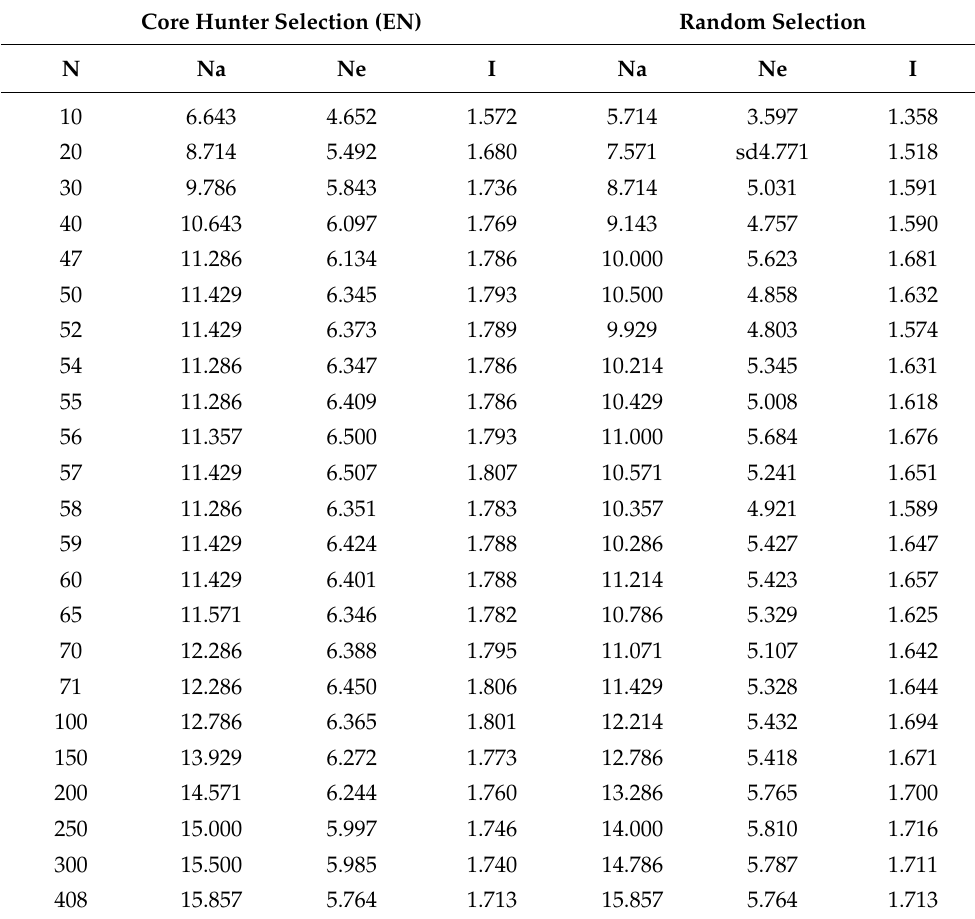
Table 2. Frequency-based